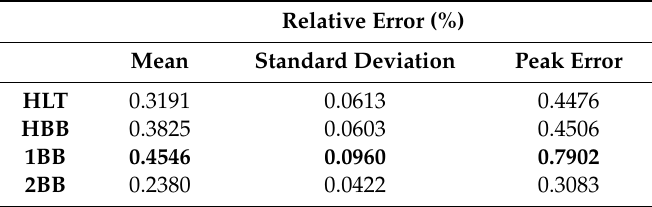
Table 1. FPGA-based implementation